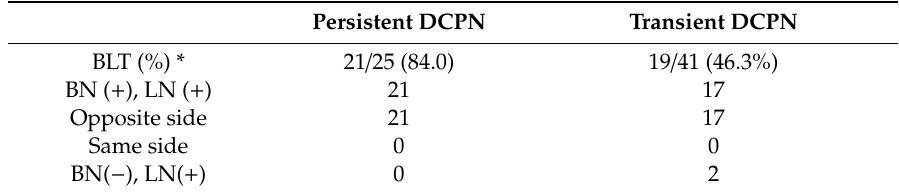
Table 2. Result of bow and lean test (BLT) and null plane between persistent and transient geotropic DCPN (direction-changing positional nystagmus).